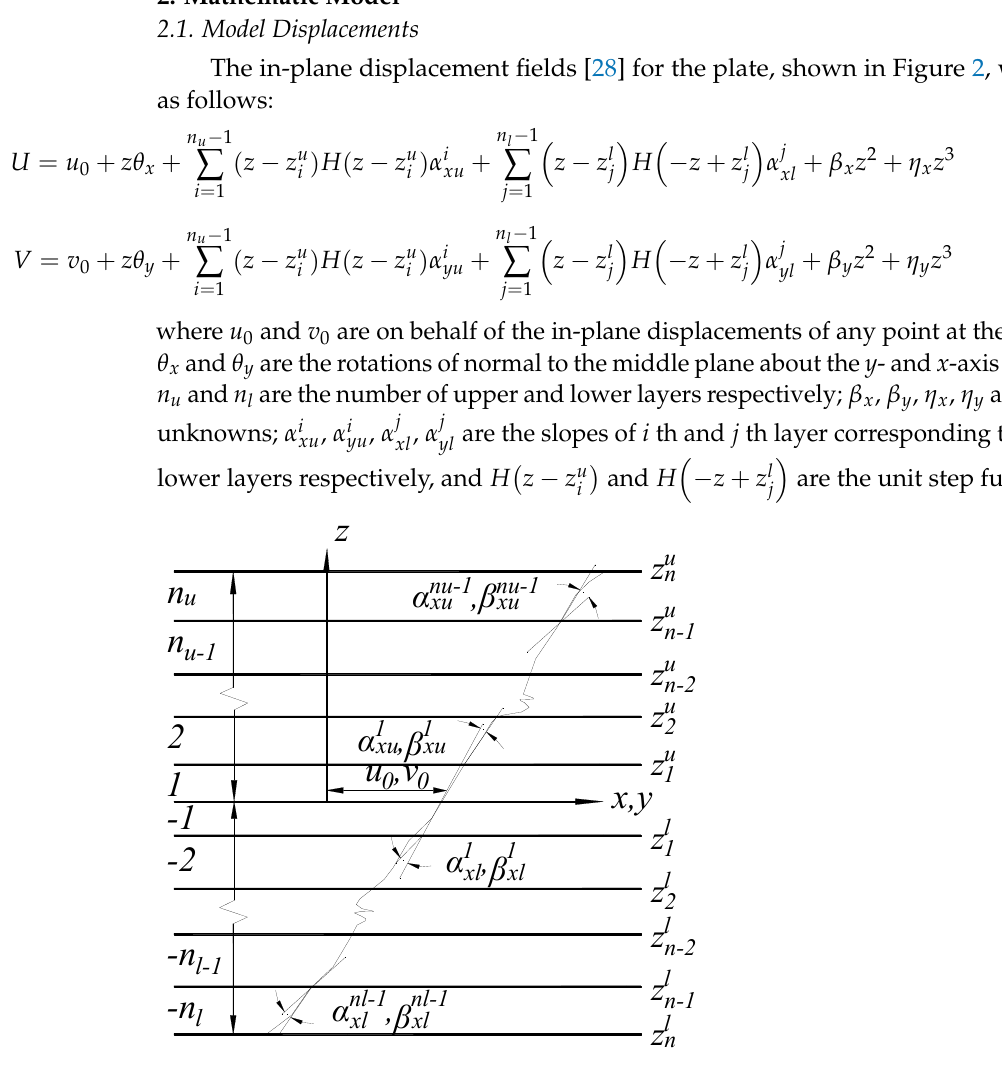
Figure 2. In-plane displacement fields in laminas.